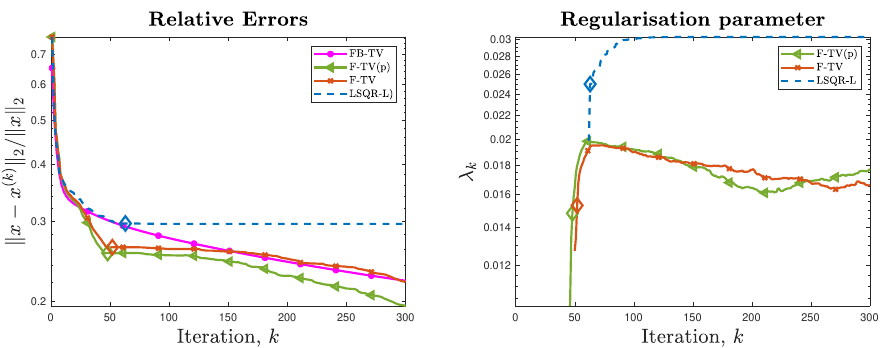
Figure 2. Experiment 1, with N = 32 . ( Left frame ): History of the relative error norms, comparing FBTV, F-TV, F-TV(p), and LSQR-L. ( Right frame ): History of the automatically selected regularization parameter for the projected problem (for the F-TV, F-TV(p), and LSQR-L methods), according to the discrepancy principle (29). Diamond markers indicate the iteration at which the stopping criterion (31) is satisfied.